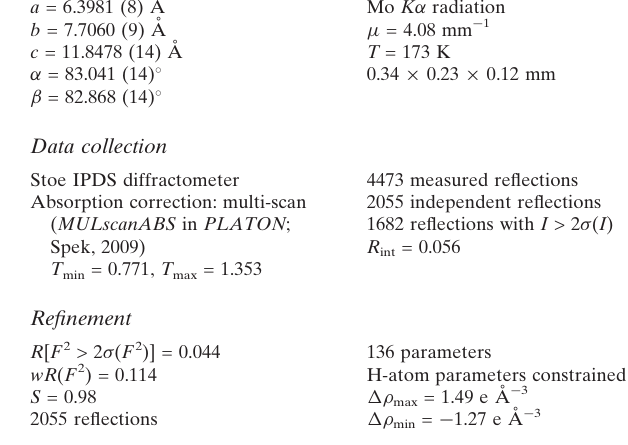
Data collection Stoe IPDS diffractometer Absorption correction: multi-scan